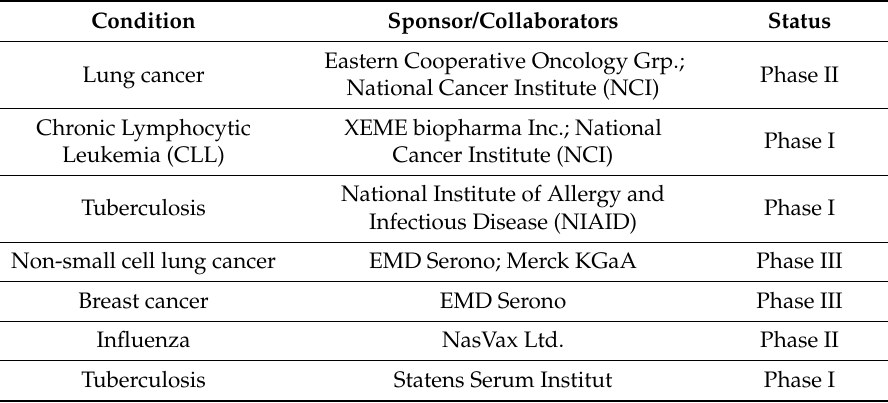
Table 3. Selected clinical studies involving liposomal carrier